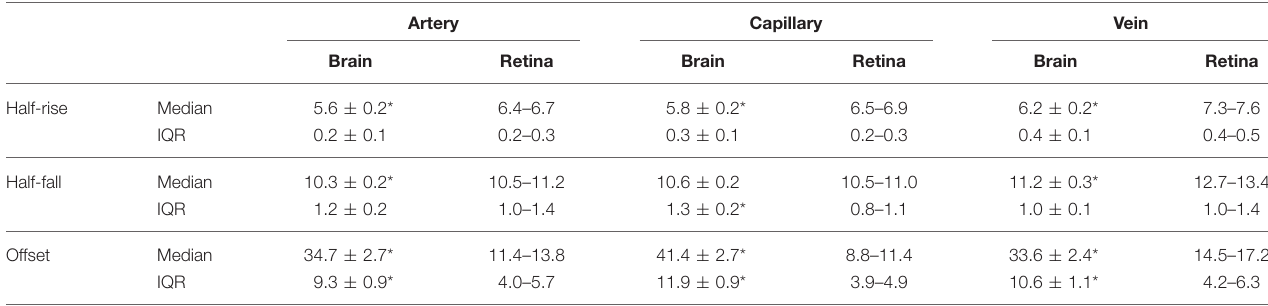
TABLE 1 | Distribution of the median and inter-quartile range (IQR) for the half-rise (s), half-fall (s), and offset (%) for each cortical vessel type compared to the bootstrapped 95% CL for the retina.